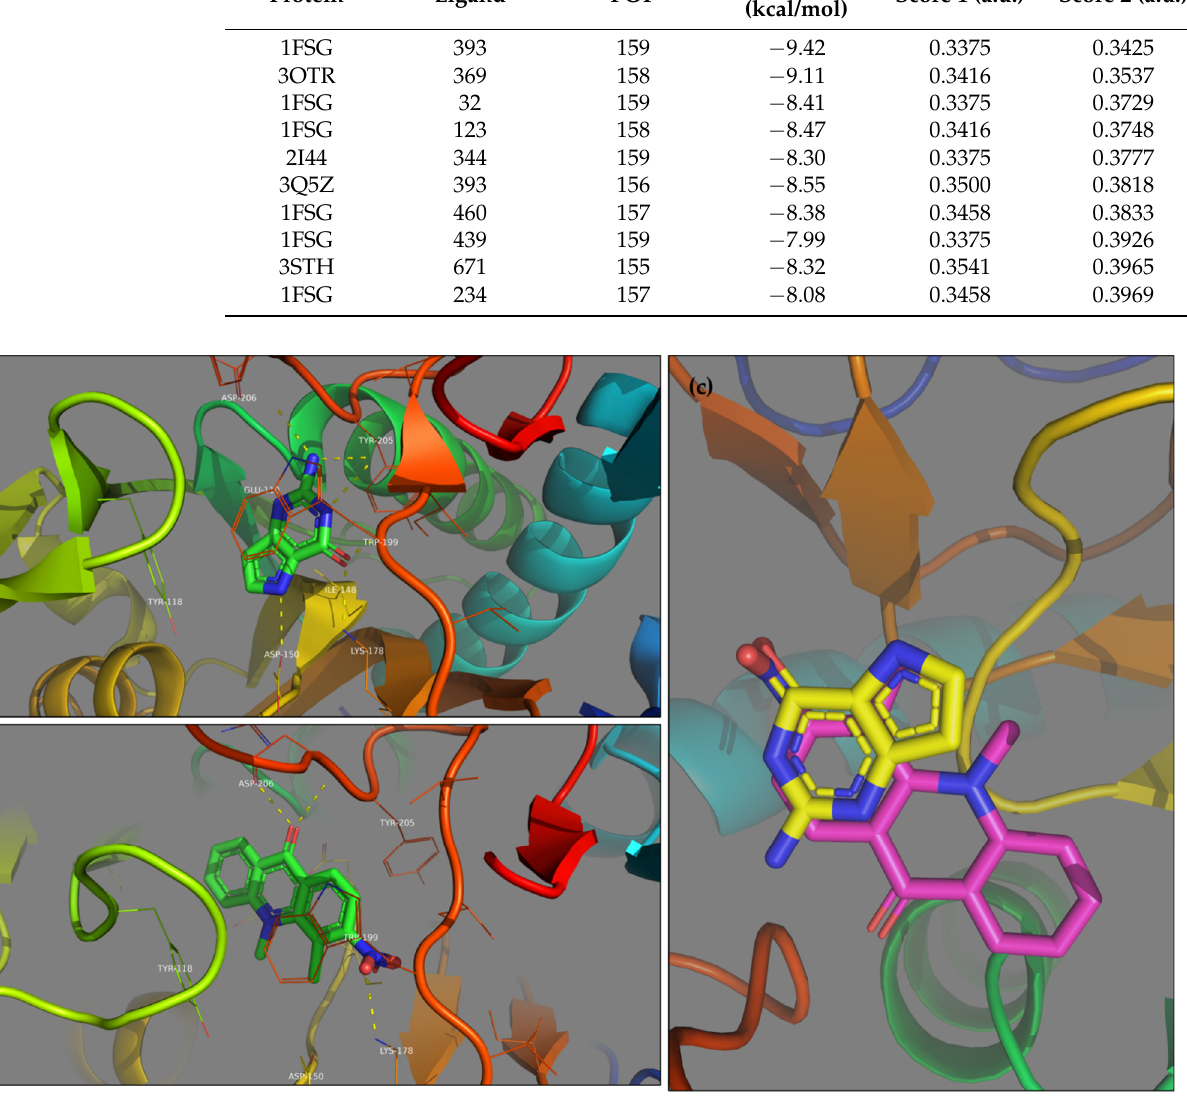
Figure 5. Comparison of the positions of the co-crystallized 9DG ligand ( a ) and the top ligand 393 ( b ) on 1FSG protein. Superposition of the poses of the co-crystallized 9DG ligand and the top ligand 393 ( c ). Both are placed in the same pocket and at least three hydrogen bonds (dashed yellow lines) are highlighted between ligands and residues LYS-178, TYR-205 and ASP-206. π -stacking is observed in the two cases for residue TRP-199.